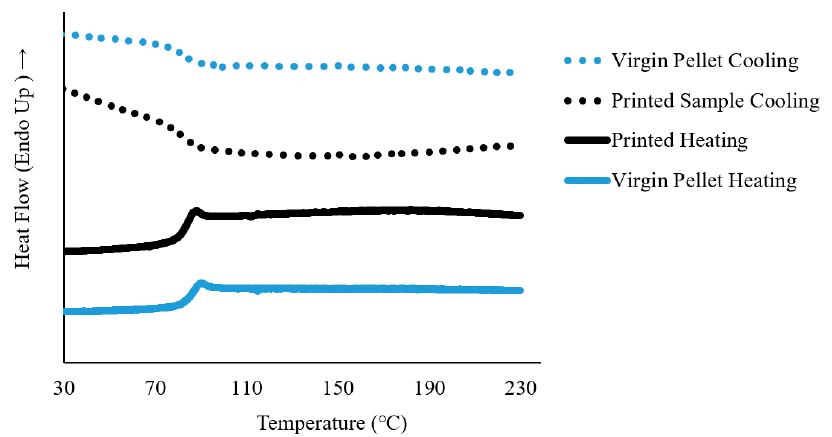
Figure 5. DSC Heat flow thermogram of the second heating and cooling cycle of the virgin pellet, and printed Diaplex 9020 sample.